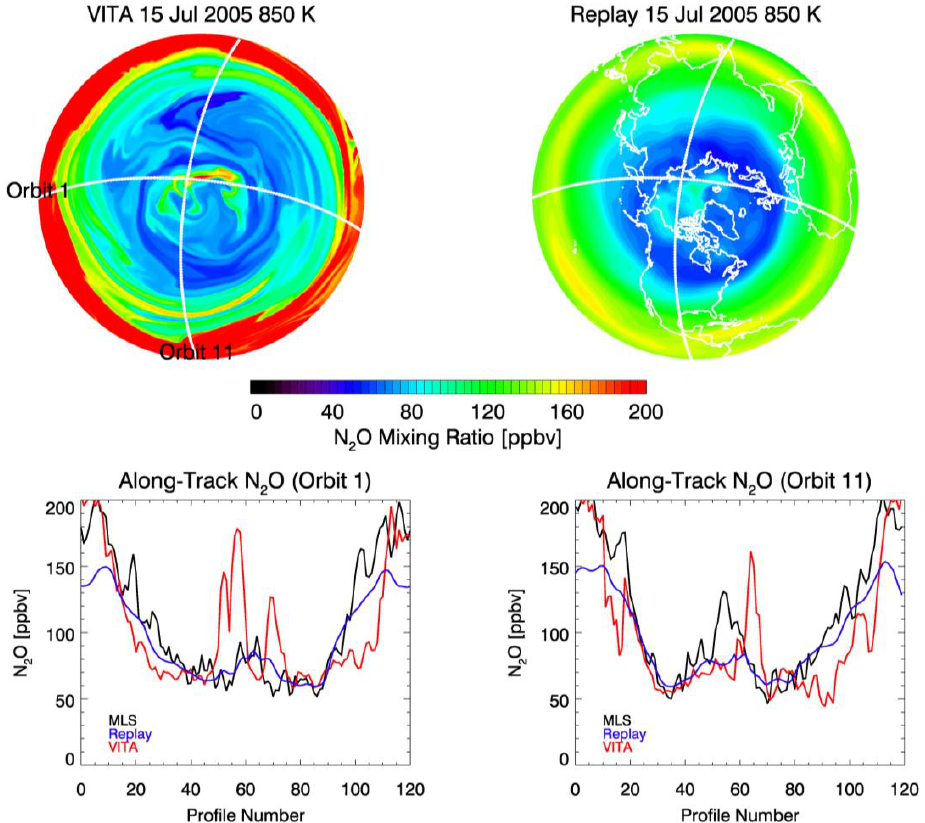
Fig. 15. Top row: Northern Hemisphere VITA (left) and Replay (right) N 2 O at 850K on 15 July 2005. Red (blue) indicates high (low) N 2 O values. Overlaid are two EOS Aura MLS orbit tracks for this day. Second row: MLS, Replay, and VITA N 2 O at 850K along the selected orbit tracks. The profiles start at the locations of the orbit labels in the upper left panel. Replay and VITA data are interpolated linearly in space and time to the MLS data points.